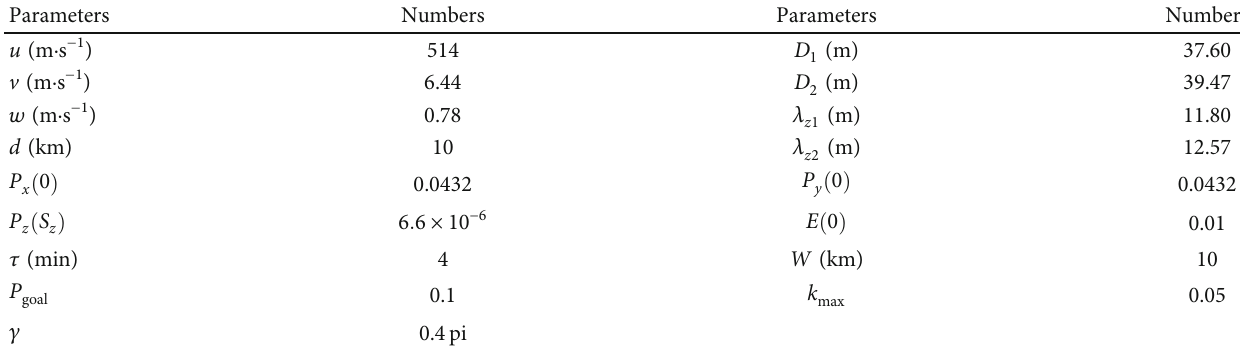
Table 3: Event lateral con fl ict model parameter setting table based on TSRRT.